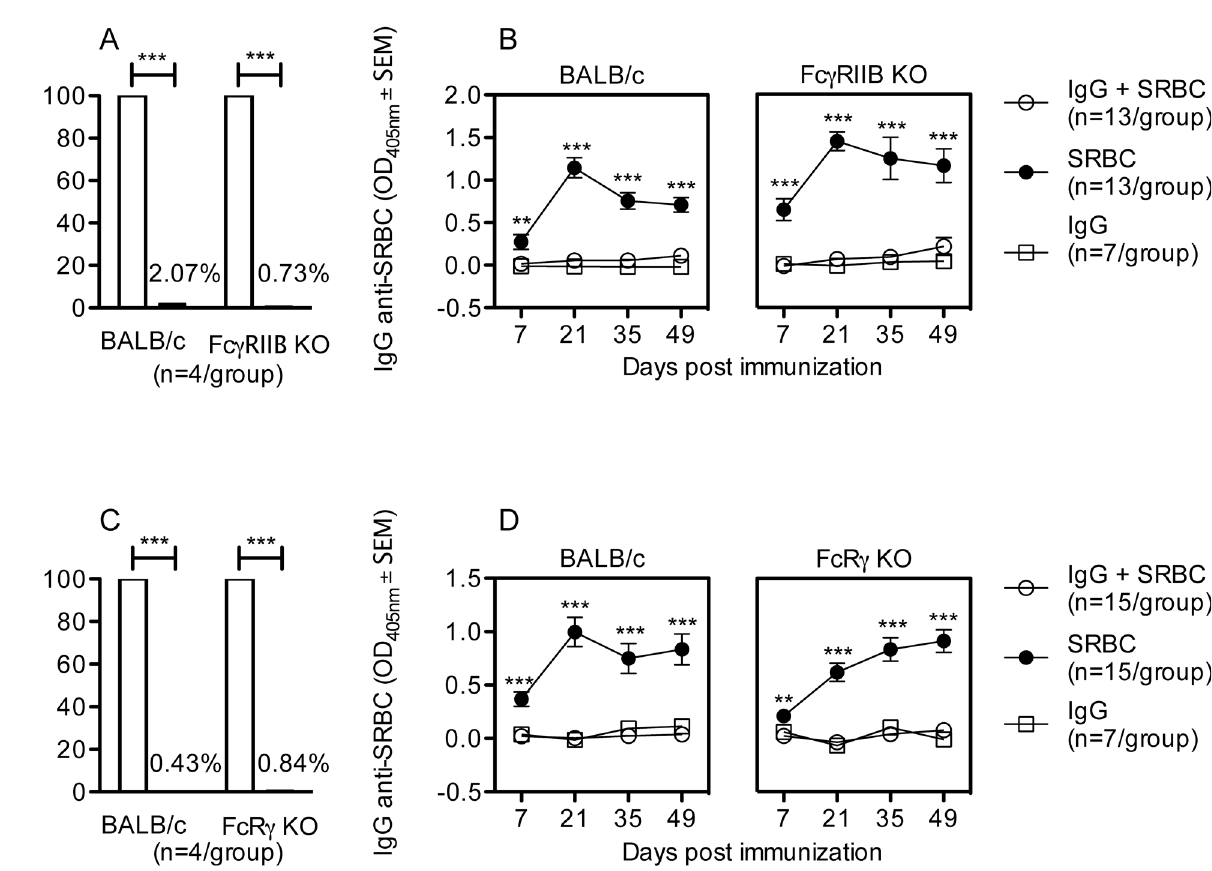
Fig 3. IgG-mediated suppression of primary IgM- and IgG-responses in Fc γ RIIB KO and FcR γ KO mice. Fc γ RIIB KO, FcR γ KO, and BALB/c mice were immunized with 10 μ g IgG b anti-SRBC and 5x10 6 SRBC, SRBC alone, or IgG alone. (A,C) Five days after immunization, the number of spleen cells producing IgM anti-SRBC was assayed. Responses are shown as percentage of the direct PFC response/spleen in mice given SRBC alone (100%, open bars); black bars show responses in mice given IgG and SRBC. Direct PFC/spleen in the respective control groups (receiving antigen alone) were in A: BALB/c, 12,218; Fc γ RIIB KO, 36,391 (p < 0.05) and in C: BALB/c, 57,279; FcR γ KO 40,831. (B,D) Seven to 49 days later, serum levels of IgG anti-SRBC were assayed in ELISA on sera diluted 1:625. Data are representative of one (A, C) or pooled from three (B, D) experiments with each KO strain. p-values denote comparisons between mice immunized with IgG anti-SRBC together with SRBC and mice immunized with SRBC alone. ** , p < 0.01; *** , p < 0.001.